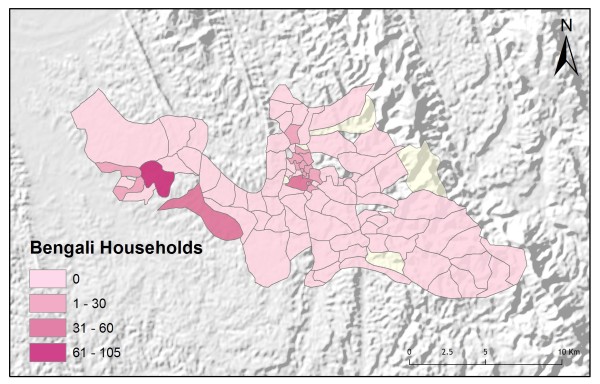
Bengali population.